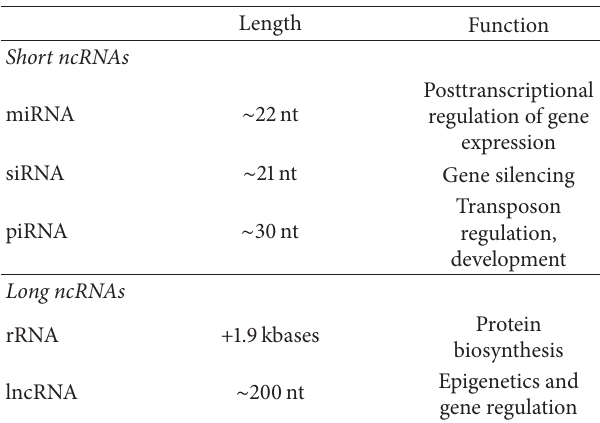
Table 1: Categories, characteristics, and functions of selected